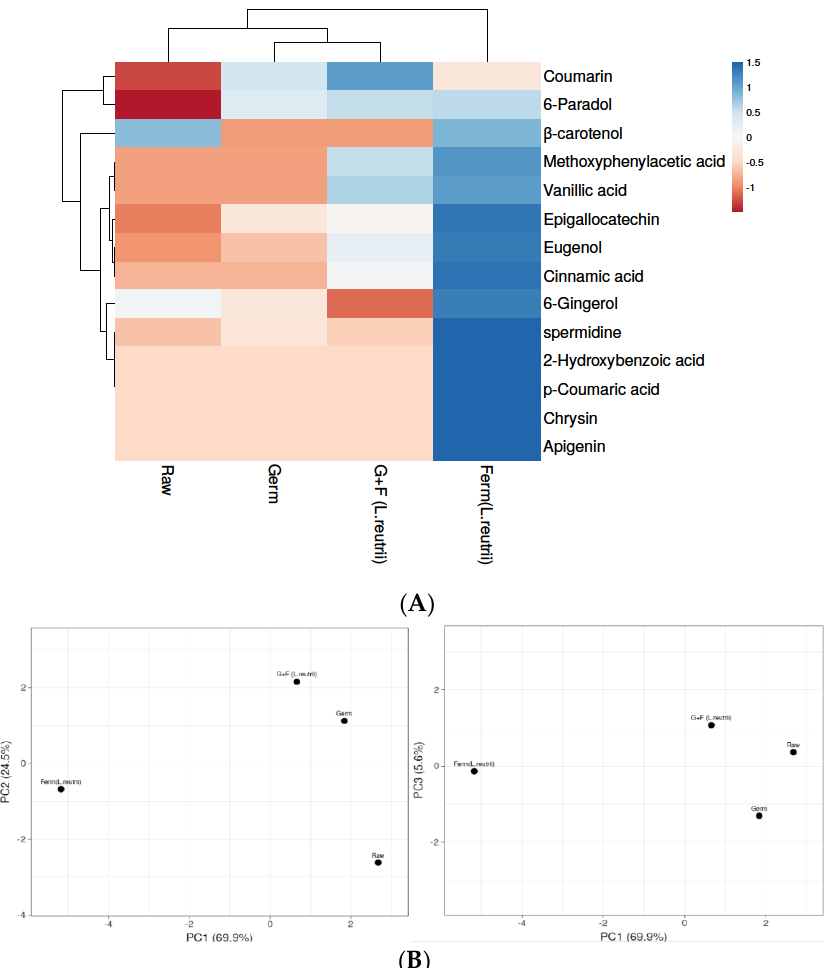
Figure 3. Levels of phenolic compounds in raw, germinated, fermented ( L. reuterii AKT1) and G+F ( L. reuterii AKT1) samples. ( A ) The heat map shows different levels of phenolic compounds in samples based on colors from blue to red, representing the level of phenolic compounds in decreasing order. ( B ) Identification of principal component analysis (PCA) of Raw, Germ, Ferm ( L. reuterii ) and G+F samples was shown by comparing PC1 with PC2 and PC1 with PC3. Germ- germinated brown rice, Ferm- fermented brown rice, G+F-germinated + fermented brown rice.